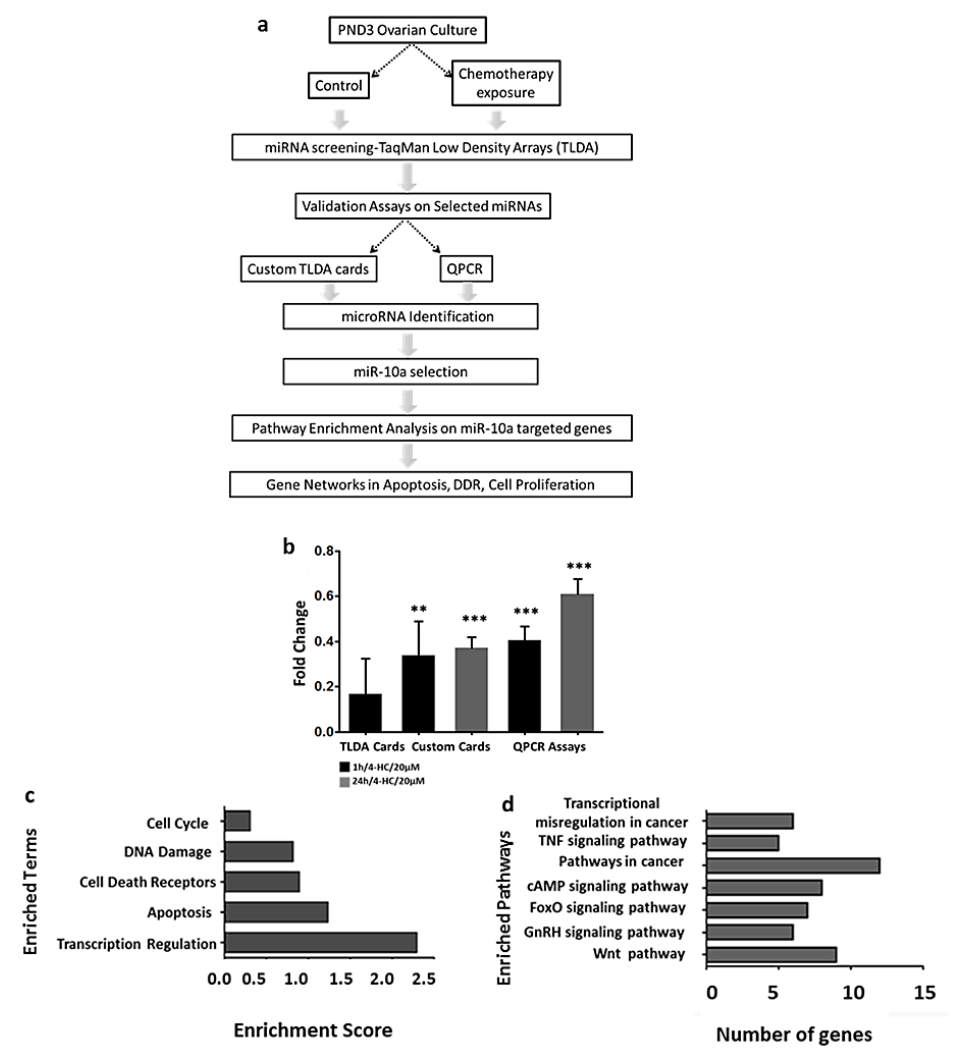
Figure 1. Study’s workflow for Identification of the miRNAs with ovarian protective potential . ( a ) Diagrammatic representation of study’s workflow and findings. The miRNA profiling was performed in PND3 ovaries cultured in vitro under control (culture medium) and chemotherapy exposure (4-HC / 20 µ M). ( b ) TLDA arrays revealed that miR-10a is di ff erently expressed after 1 h of chemotherapy exposure ( n = 3 pairs), and the two-steps validation assays further confirmed that miR-10a was significantly downregulated after 1 h and 24 h of exposure. Validation included custom cards ( n = 10 pairs / 1 h, n = 6 pairs / 24 h) and QPCR assays ( n = 13 pairs / 1 h, n = 15 pairs / 24 h). The fold change is expressed as the geometric mean. The error bars correspond to standard error. ** p -value < 0.005, *** p < 0.001 by paired t-test. ( c ) Pathway enrichment analysis on the DAVID database validated by miRTarBase and ( d ) predicted targets by the TargetScan of miR-10a. MiR-10a target genes that have a key role in DNA damage response, apoptosis pathways, and cell proliferation.